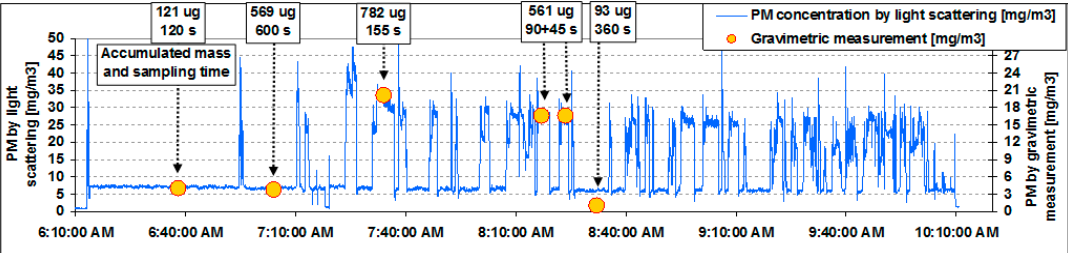
Figure 7. Comparison of particulate matter concentrations measured dynamically by light scattering with gravimetric measurements conducted during steady-state operation at idle and high load.